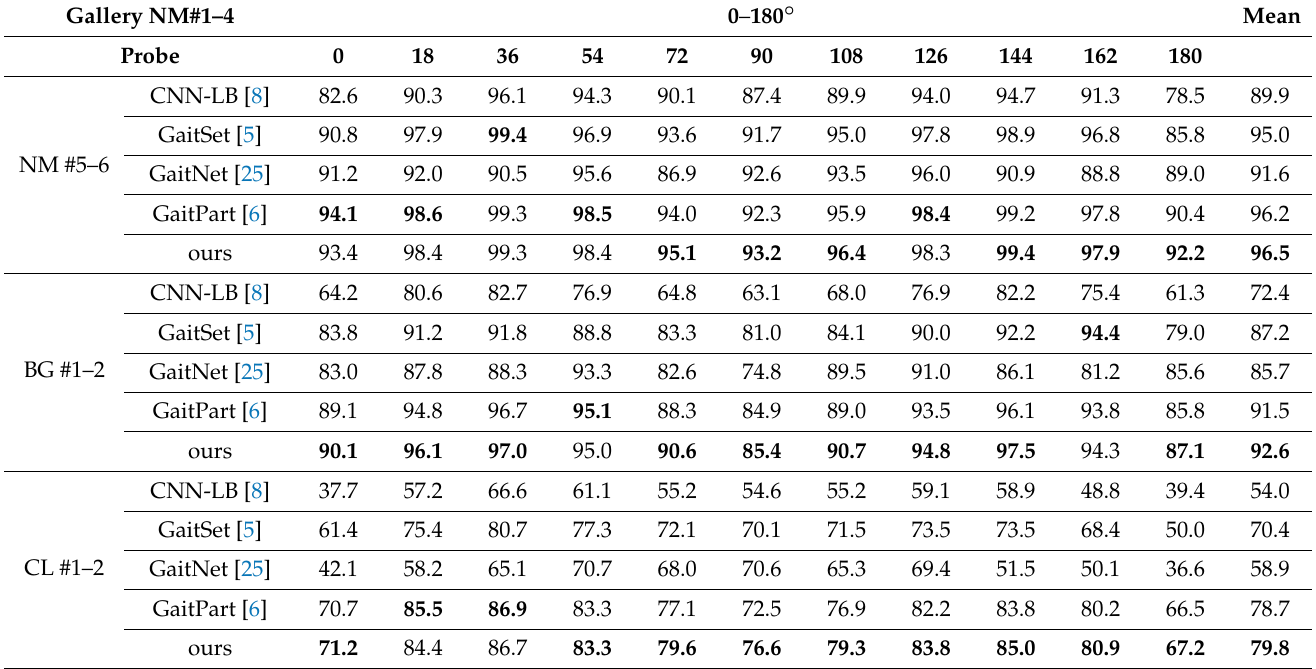
Table 3. Comparative experimental results in the CASIA-B [20] dataset among the proposed method and other methods, excluding identical-view cases. The bolds indicate the best accuracy in this